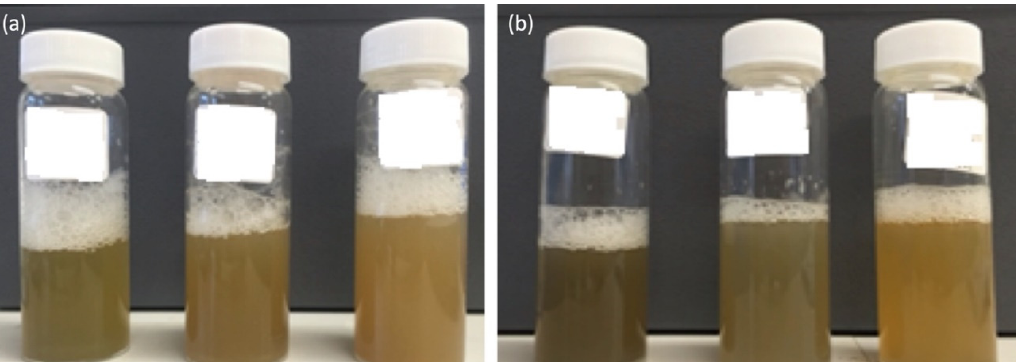
Figure 11. The effect of pH on the particle size of iron-entrapped WPI-CS nanoparticles produced using low MW chitosan.